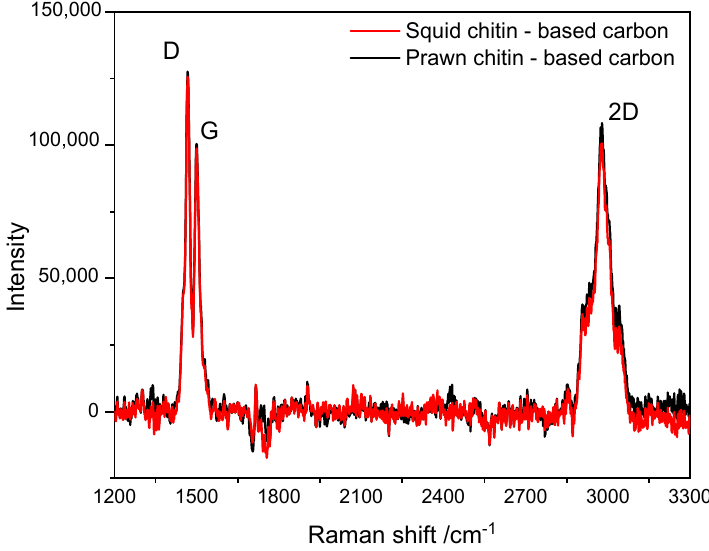
Figure 6. Raman spectra of the chitin-based carbons.